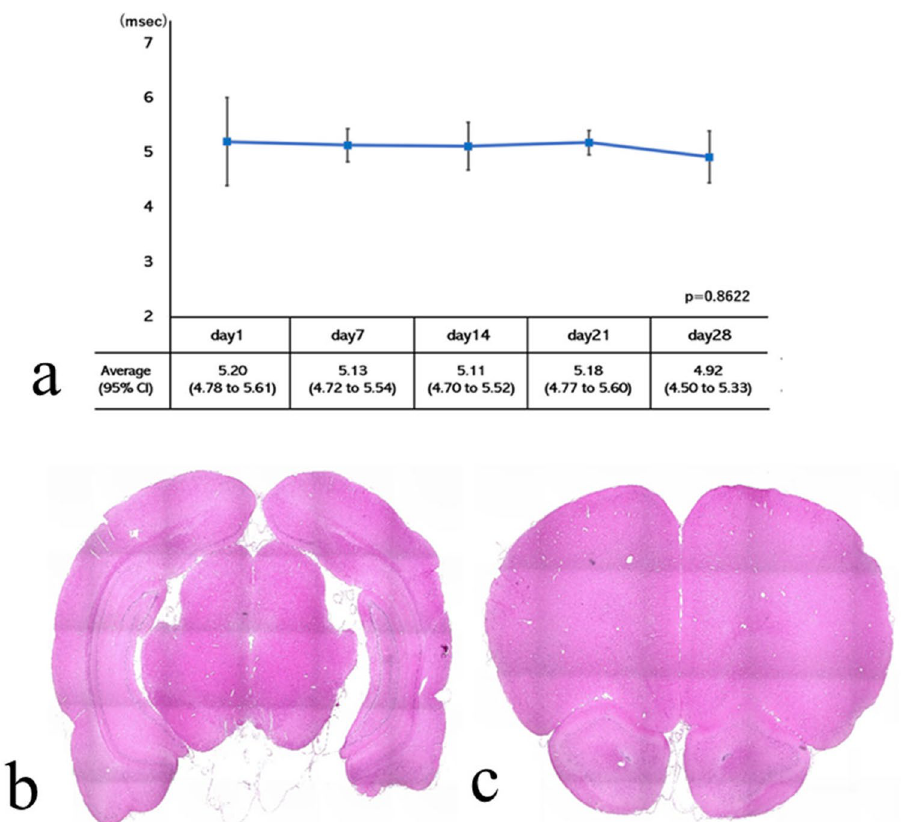
Figure 2. ( a ) Time course of the latency of transcranial electrical stimulated motor-evoked potentials. Repeated measures analysis of variance was performed on weekly measurements. P -value = 0.8622. CI = confidence interval. ( b ) A pathological image of a coronal section of the frontal lobe, located directly under the bregma. ( c ) Coronal section of the parietal lobe located directly under the lambda. There was no cerebral contusion or atrophy associated with this experiment.